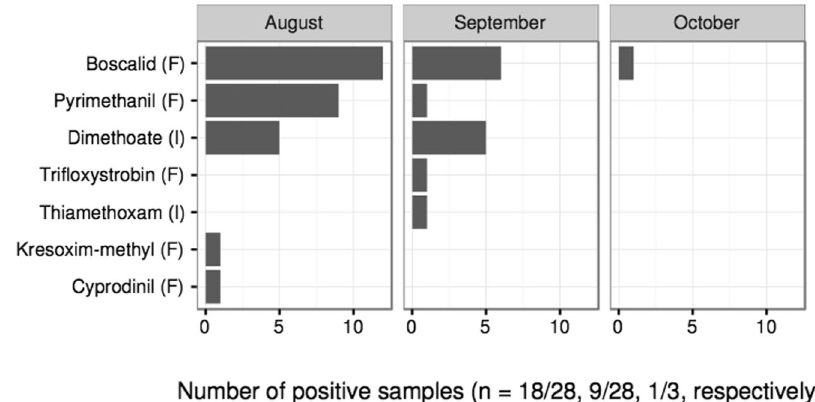
Figure 1. Frequency of pollen contamination per month and for each pesticide. Two samples from July are not shown. No pesticides were detected in these two samples. I = Insecticide, F =